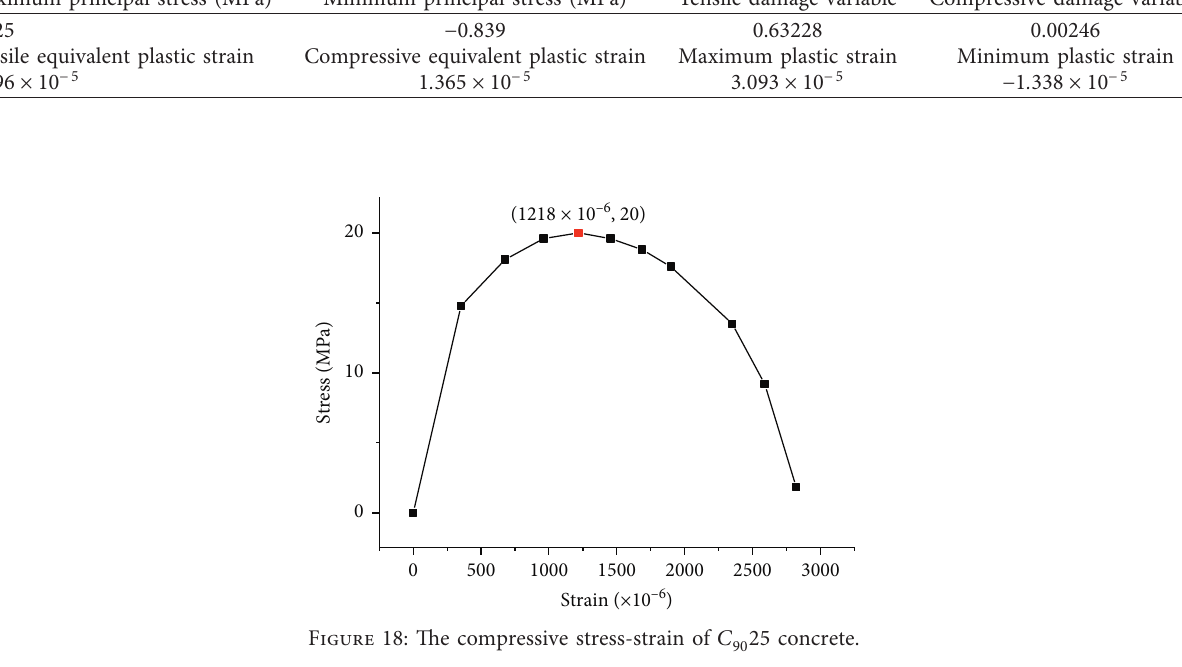
Table 2: The relevant variables at the integral point of the dam heel for the overload coefficient of 1.0 at 5.82s. Maximum principal stress (MPa)